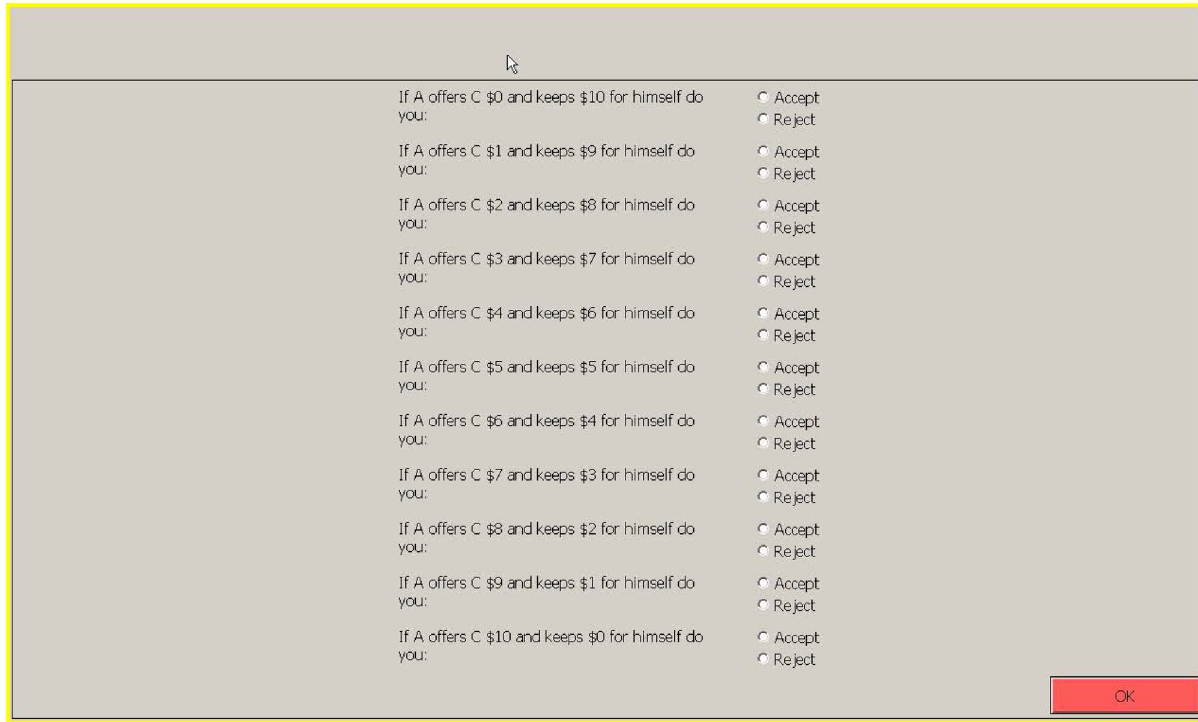
Fig 1. Arbiter’s